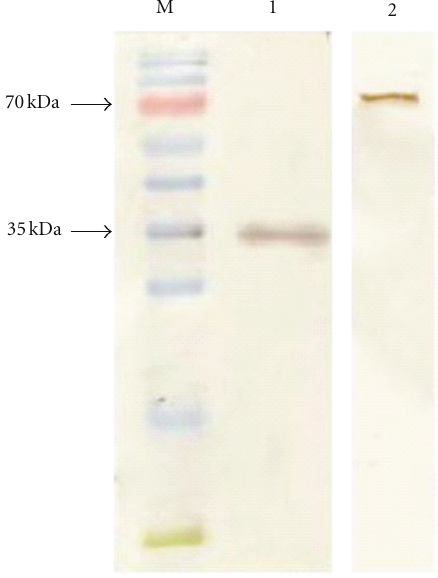
Figure 1: SDS-PAGE analysis of purified soluble pyrophosphatase (Mthe 0236) and AMP-dependent ACS (Mthe 1194). Enzymes were purified by Strep-tactin a ffi nity chromatography. M: molecu- lar mass marker (PAGE Ruler prestained protein ladder, Fermen- tas, St. Leon-Rot, Germany), lane 1: Mthe 0236 0.5 μg , lane 2: Mthe 1194 1 μ g.